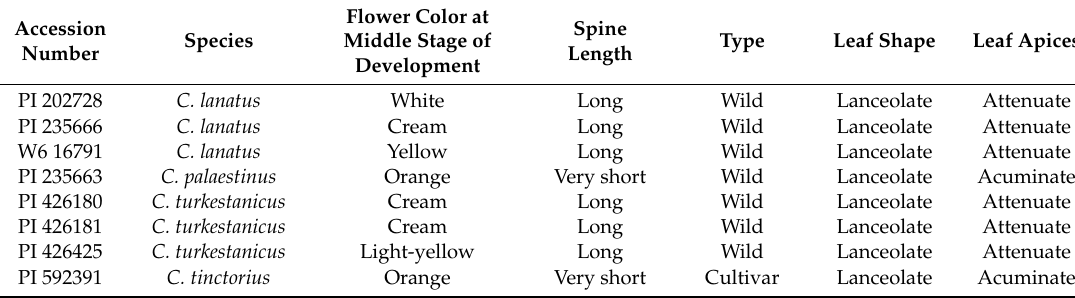
Table 2. Details of sa ffl ower ( Carthamus ) wild and cultivated species samples used in this